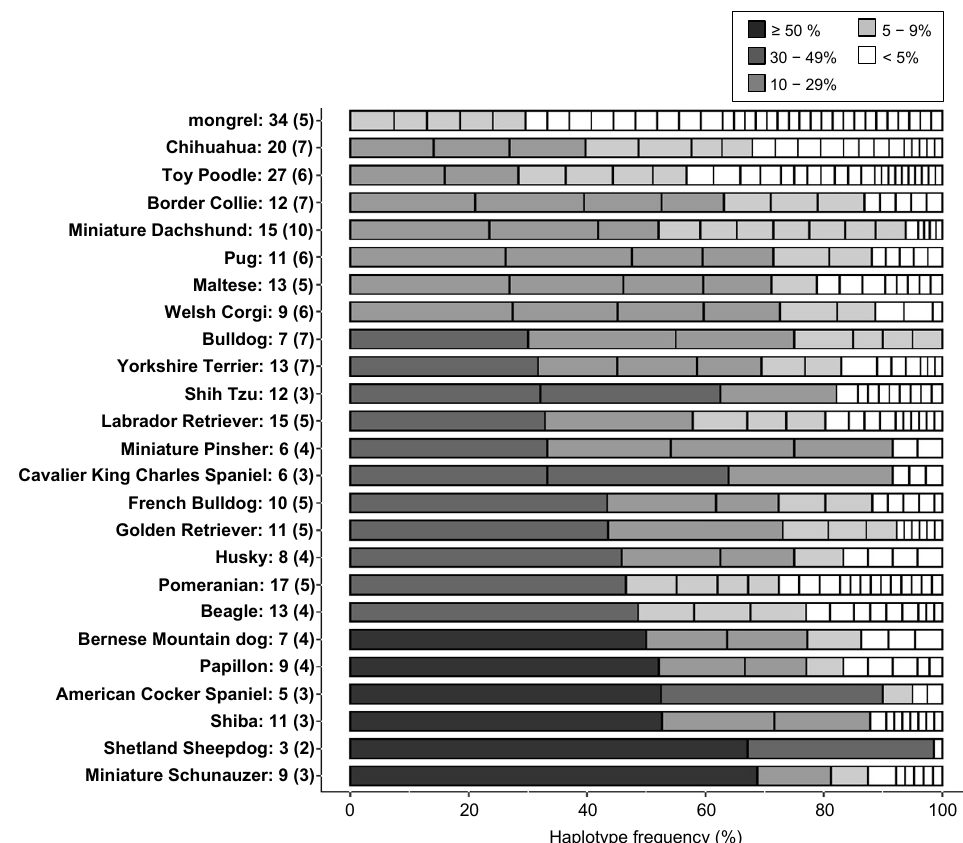
Figure 5. Percentage distribution of the 88-12/88L-DRB1 haplotypes in 24 breeds and mongrels. The cumulative bar chart is based on the frequency of all the 88-12/88L-DRB1 haplotypes detected from each breed listed in Table 5. A numeral following the breed’s name indicates the number of different haplotypes detected in each breed. Parenthesis indicates the number of different 88-12/88L-DRB1 haplotypes with a frequency of 5% or higher. The breeds are sorted in ascending order by the percentage frequency of the most frequent haplotype in each breed. For example, the graph of Miniature Schnauzer at the bottom of the figure represents a total of nine sub-haplotypes of 88-12/88L-DRB1 haplotypes with a frequency of 5% or higher for three of them at >50%, 10–29%, and 5–9%, respectively.